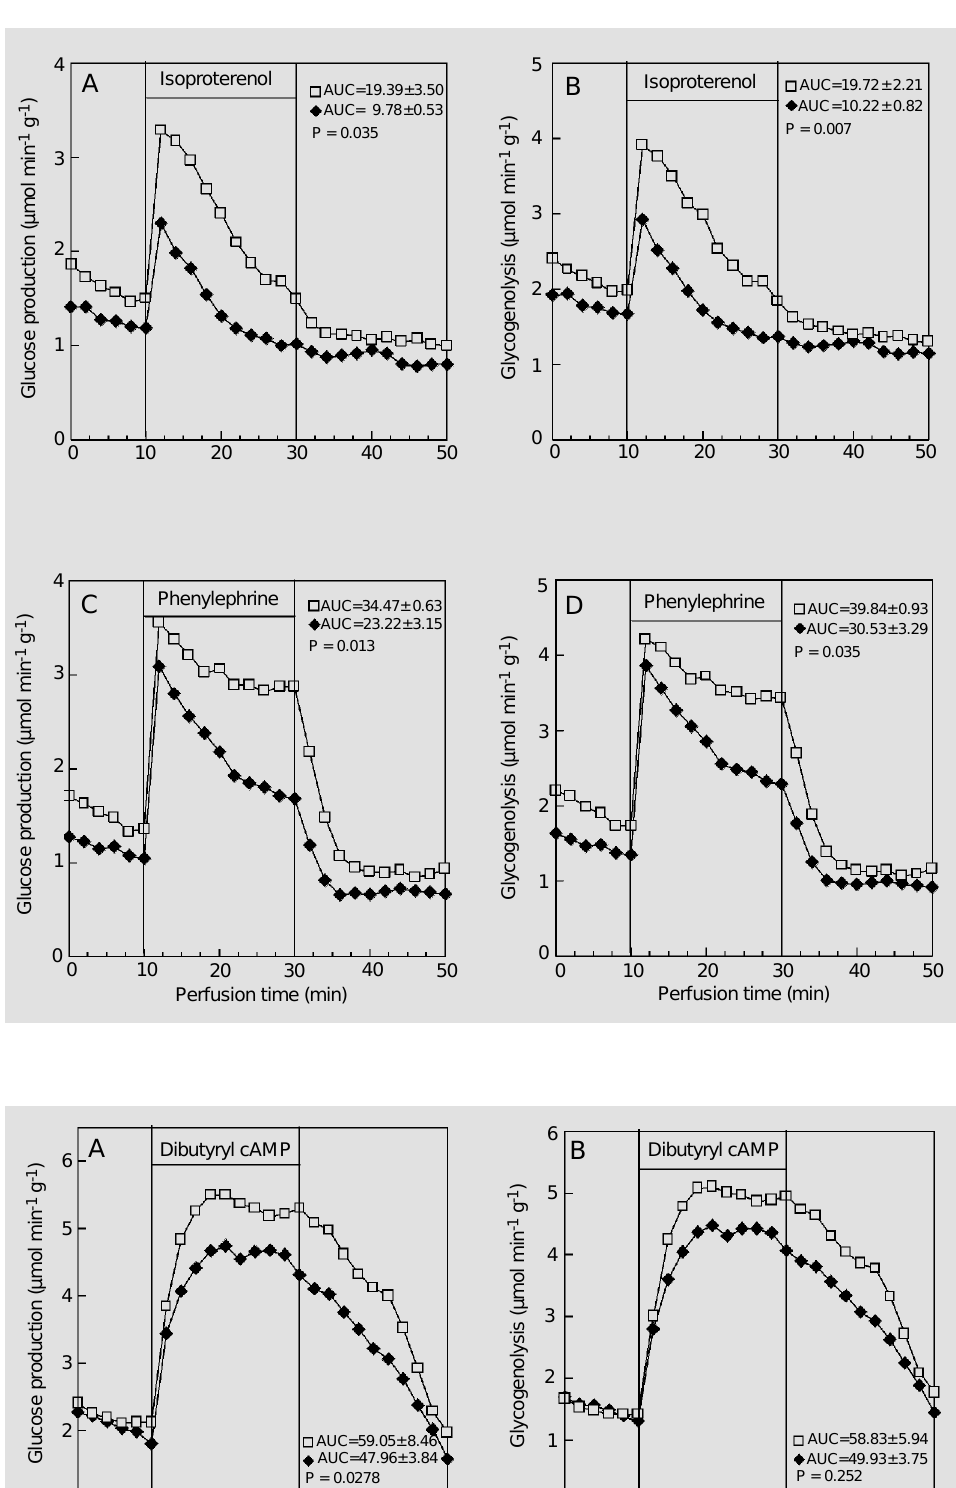
Figure 4 - Effect of isoproterenol (20 µM; panels A and B) and phenylephrine (2 µM; panels C and D) on glucose production and glycogenolysis. The data re- ported are the mean of 4 indi- vidual liver perfusion experi- ments performed 120 min after injection of saline (CN group, squares) or insulin (IN group, dia- monds). The livers were per- fused as described in Material and Methods. The IN group rep- resents non-recovered animals, i.e., rats that showed hypoglyce- mia 120 min after insulin admin- istration. AUC = Area under the curve. The statistical test used was the unpaired Student t